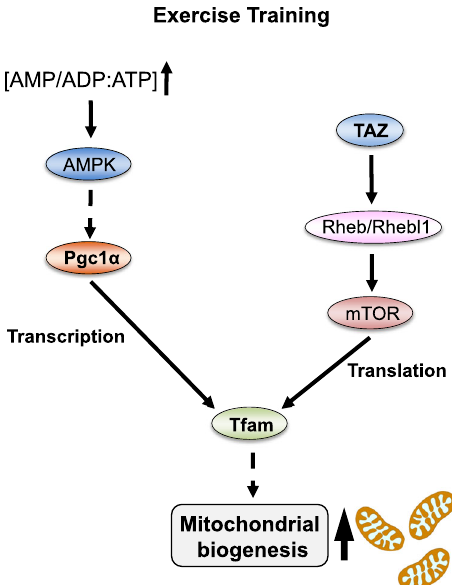
Fig. 6 Summarized model TAZ protein was stabilized and activated by exercise training. Activated TAZ translocates into the nucleus and induces Rheb/Rhebl1 expression by binding to the TEAD transcription factor. During a resting period, elevated Rheb/Rhebl1 levels amplify TORC1 signalling for upregulating the translation of Tfam mRNA. Increased Tfam protein enhances mitochondrial biogenesis by the upregulation of mitochondrial DNA replication and mitochondria-encoded gene